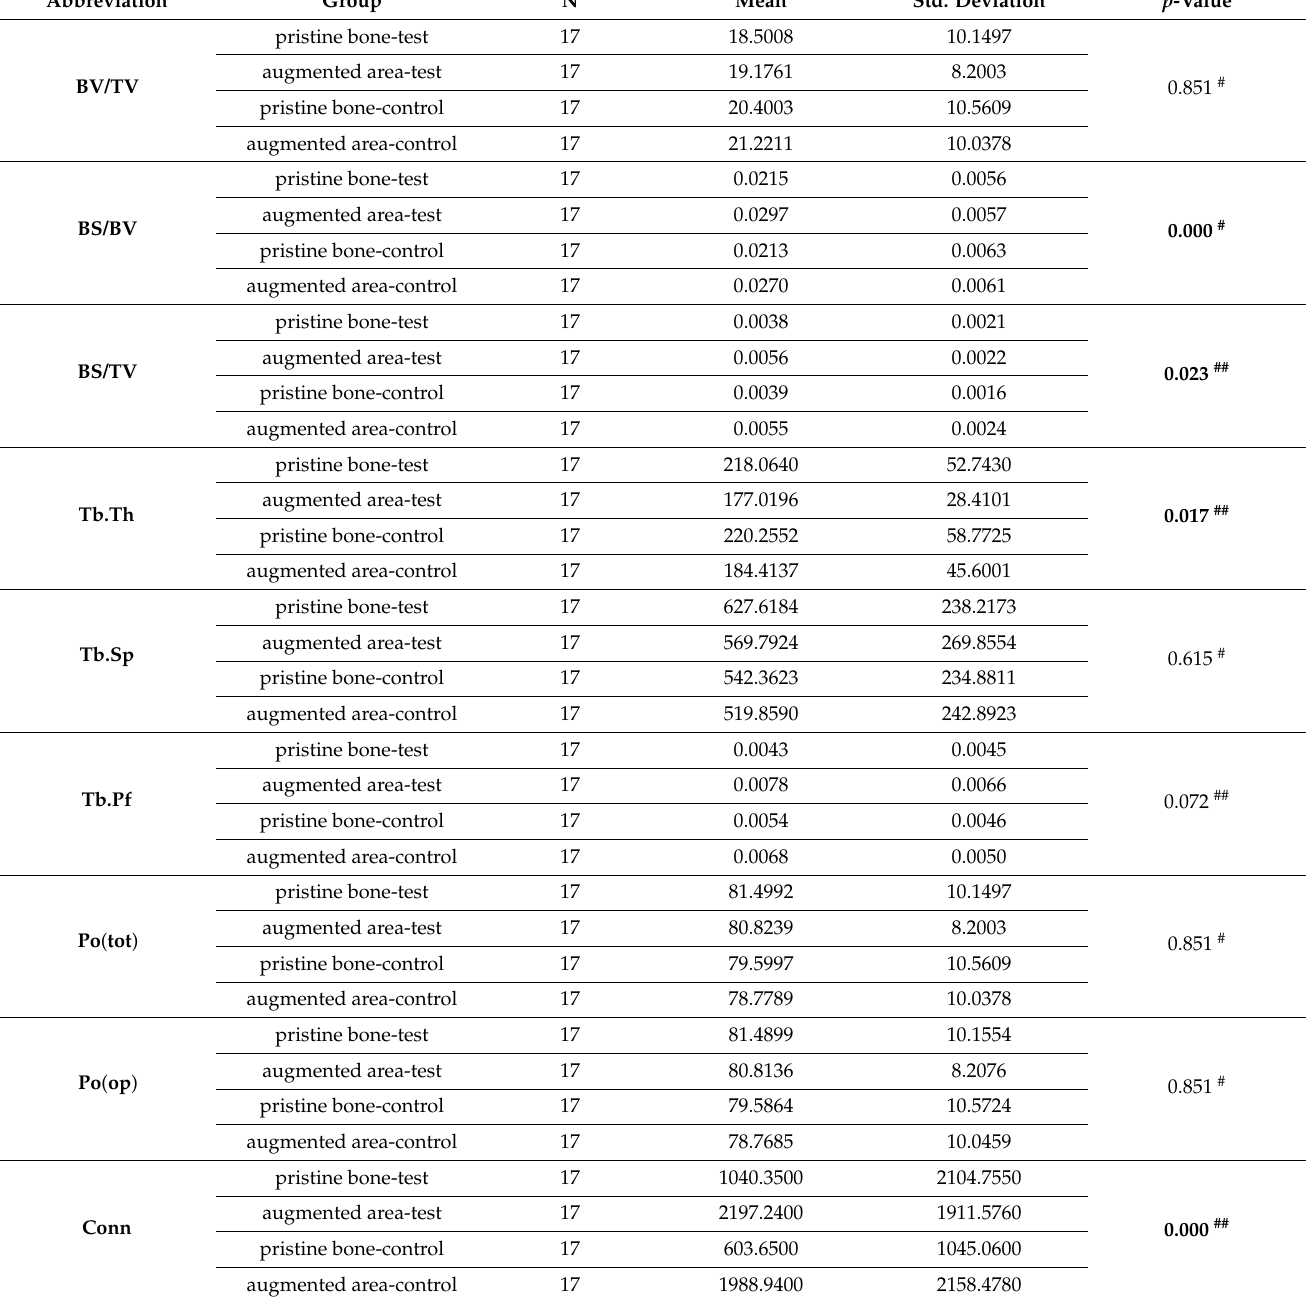
Table A1. Results of the micromorphometric analysis. Statistical significance ( p < 0.05) is highlighted in bold. Abbreviations: bone volume fraction (BV/TV), bone surface/volume ratio (BS/BV), bone surface density (BS/TV), trabecular thickness (Tb.Th), trabecular separation (Tb.Sp), trabecular bone pattern factor (Tb.Pf), total porosity (Po(tot)), open porosity